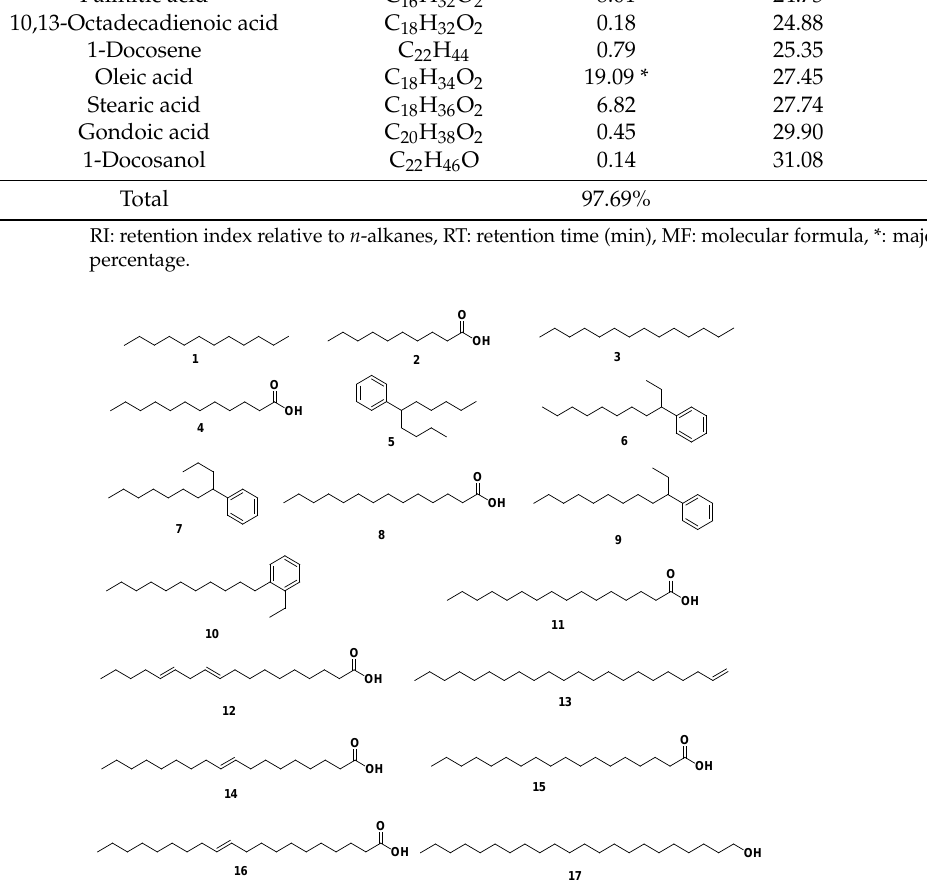
Figure 3. Structures of isolated compounds from coconut seed extract. 2.3. The Antioxidant Potential of Coconut Seed Extract The study investigated the antioxidant activity of CSE as a scavenger potential against (H 2 O 2 ). In line with the findings, the utmost H 2 O 2 radical scavenging activity of